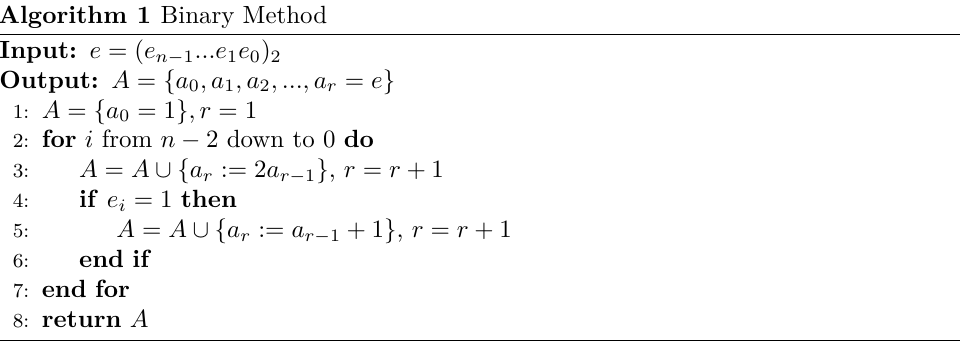
Algorithm 1 Binary